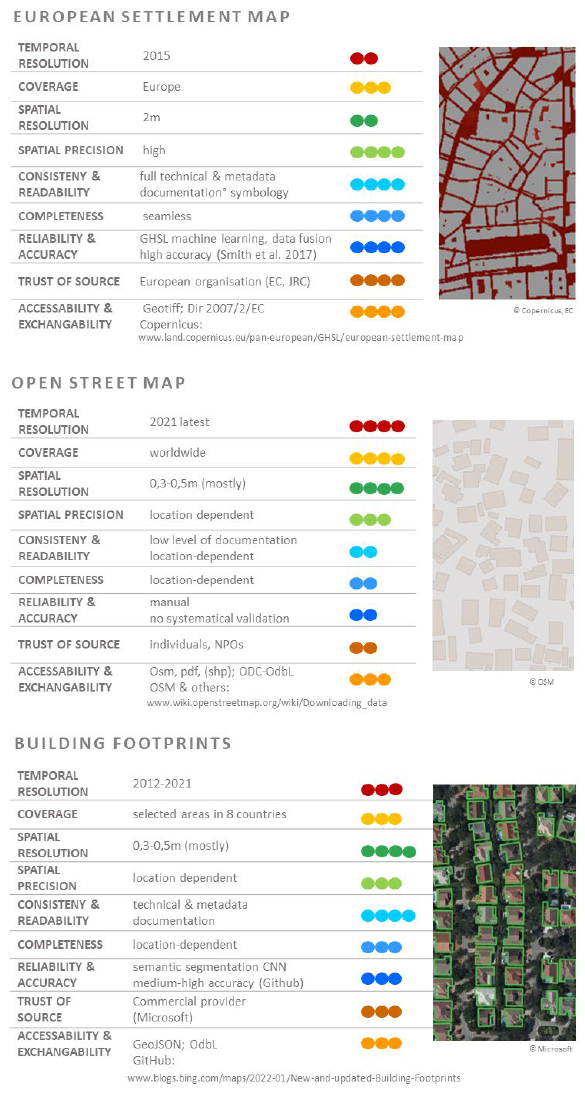
Figure 2 . Detailed assessment of usability of freely available data sources of building footprints: European Settlement Map